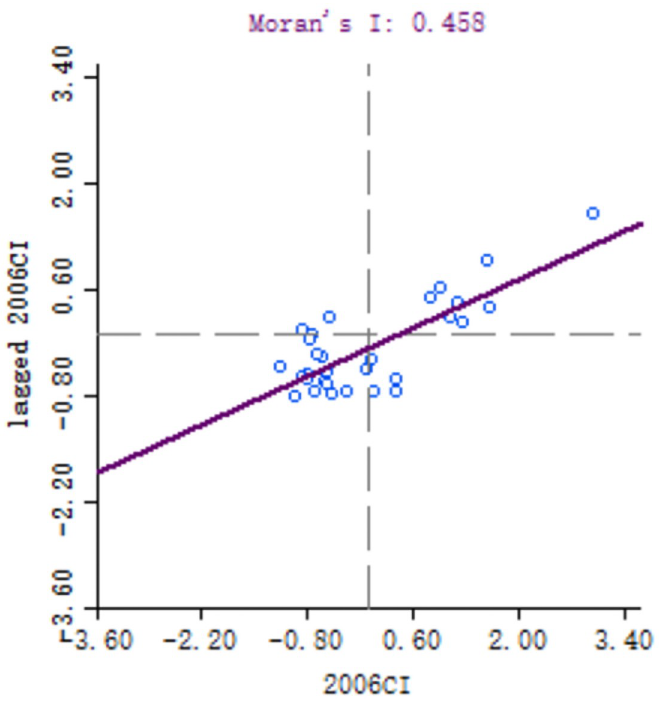
Fig 5. Moran scatter chart of industrial high quality development level in 2006.